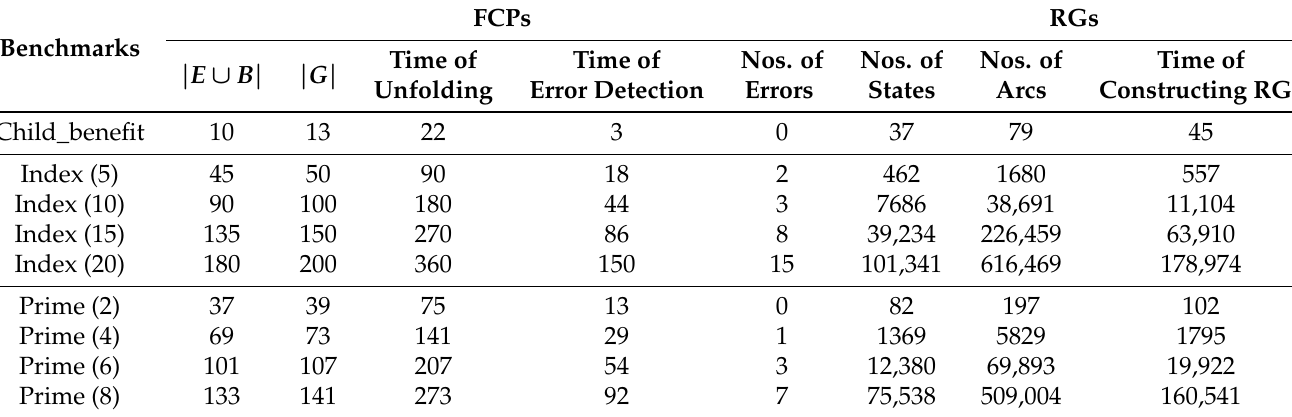
Table 5. The experimental results of unfolding PD-nets in DICER